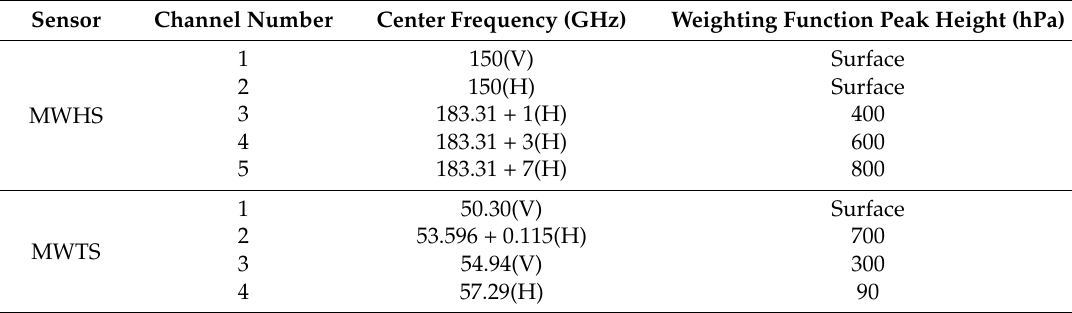
Table 1. Channel characteristics of FY-3A Microwave Humidity Sounder (MWHS) and Microwave Temperature Sounder